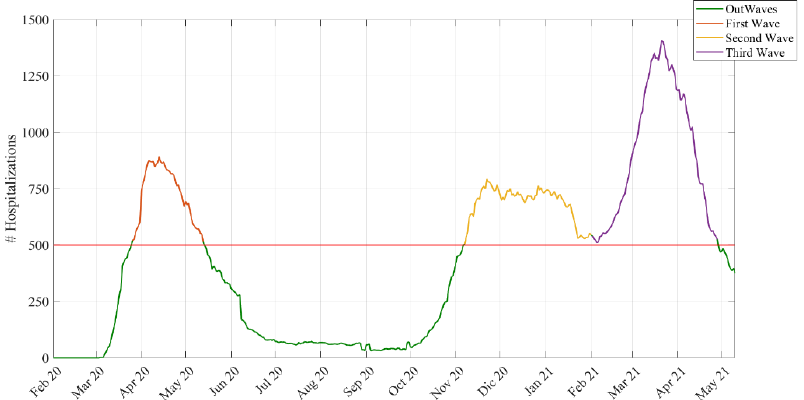
Figure 1. Number of hospitalizations over the study period and the empirical definitions of the waves.